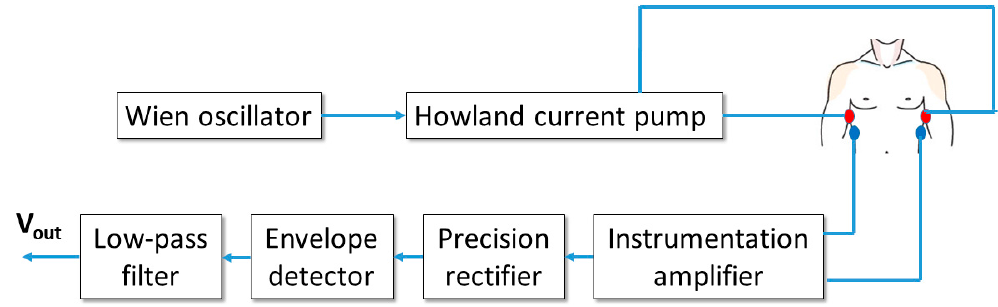
Figure 1. Scheme of the wearable instrument implementing a single acquisition channel able to simultaneously acquire impedance plethysmography and ECG signals.